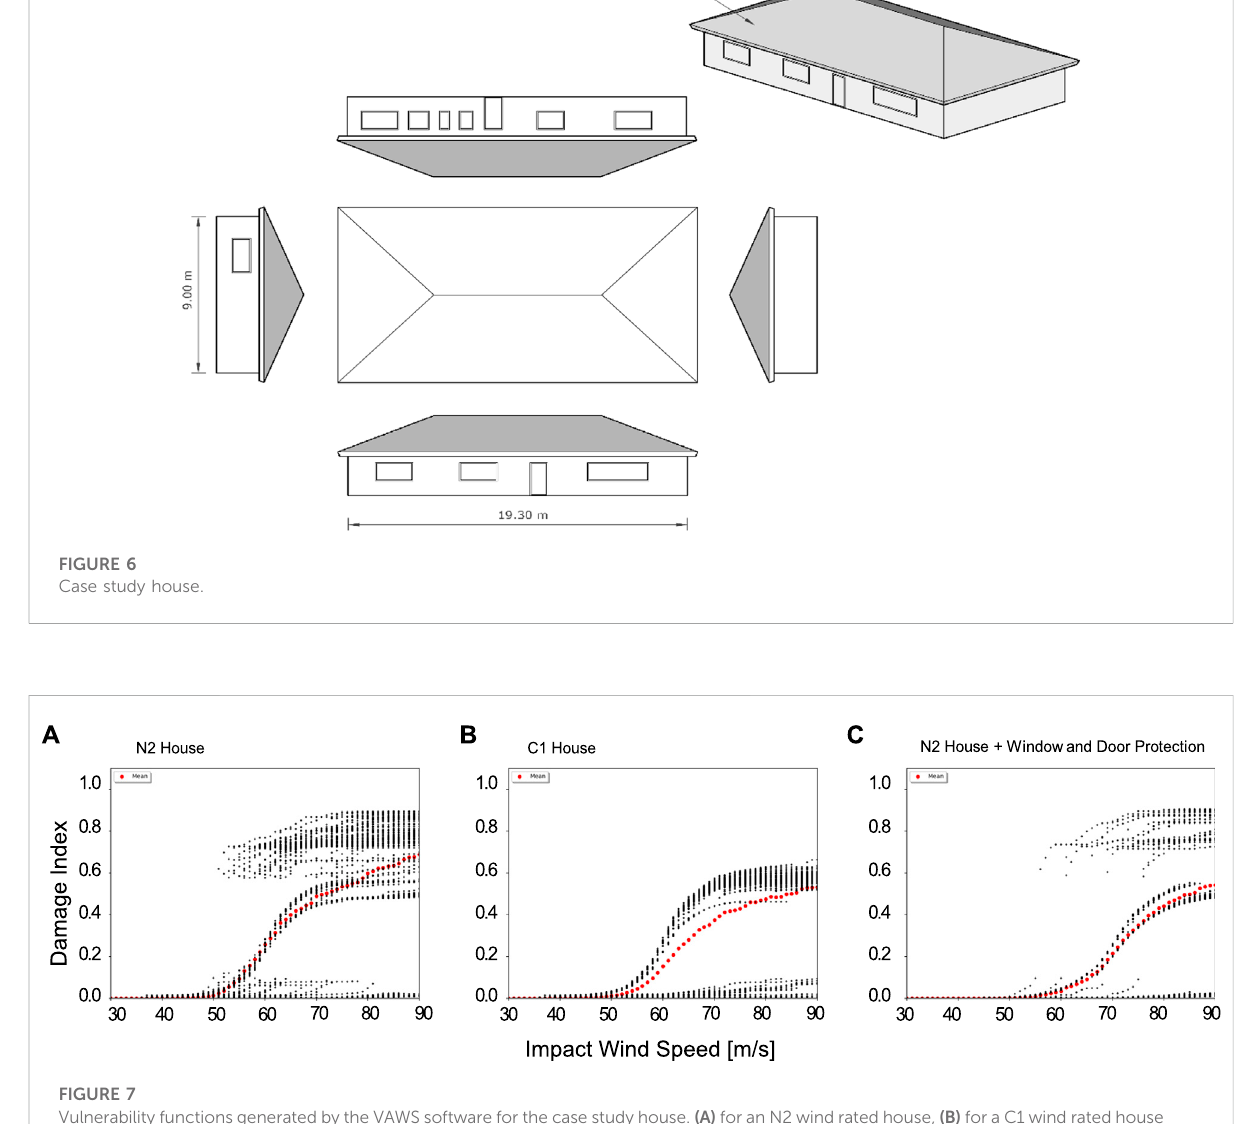
Frontiers in Built